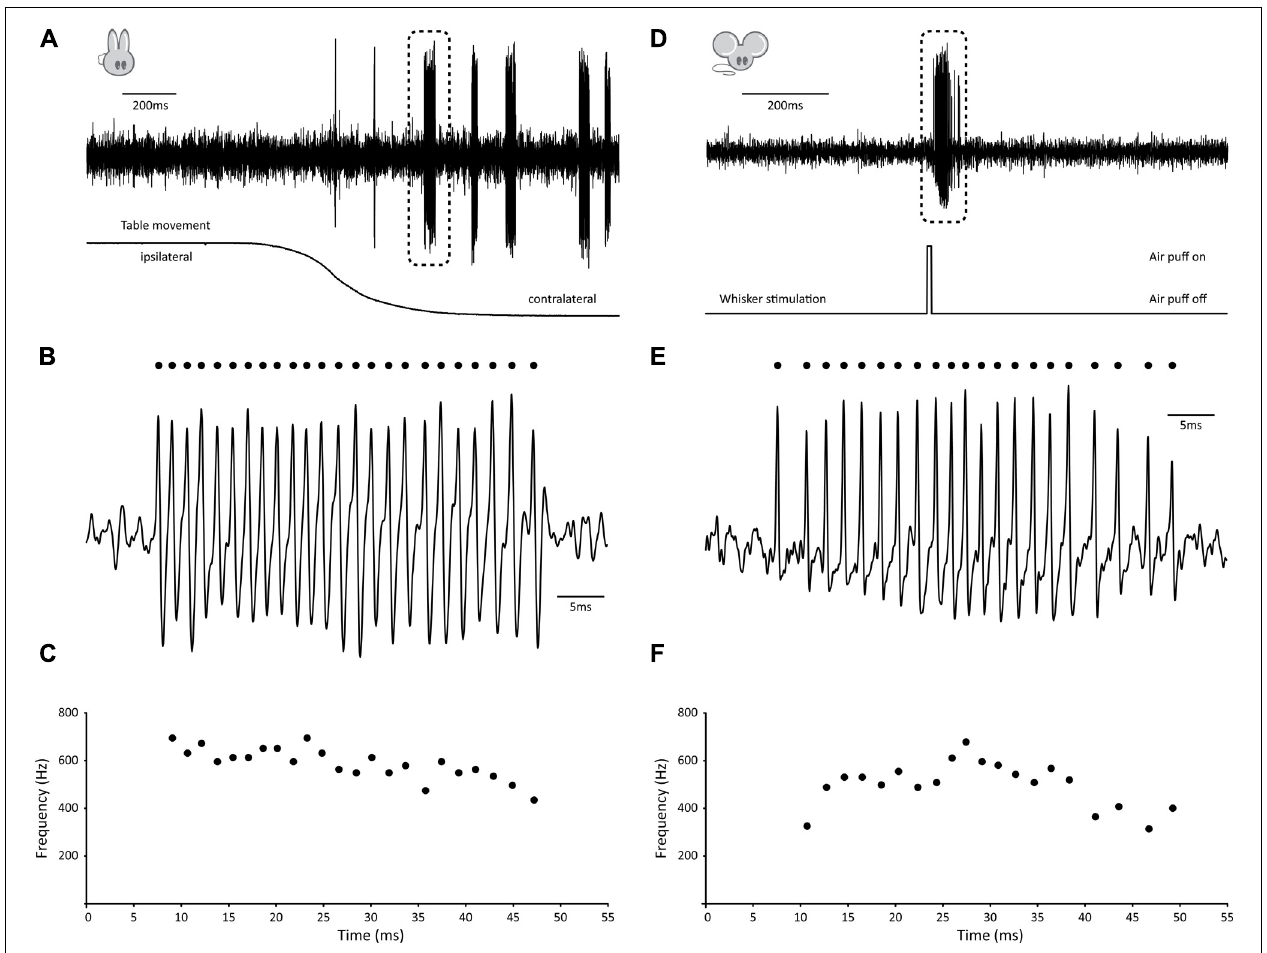
FIGURE 1 | Examples of burst firing in cerebellar granule cells. (A–C) Example of high-frequency GrC burst in the awake behaving rabbit. (A) (top) Extracellular recording of granule cell in the flocculus of a Dutch-belted rabbit during vestibular stimulation around the vertical axis. Note absence of activity prior to movement onset, whereas several distinct, high-frequency bursts occur during rotation (table position is displayed at bottom). (B) Burst demarked in A shown at larger scale. Identified spikes are indicated by dots. (C) Instantaneous frequency plot of burst shown in B.This particular burst consisted of 24 consecutive spikes with instantaneous frequencies as high as